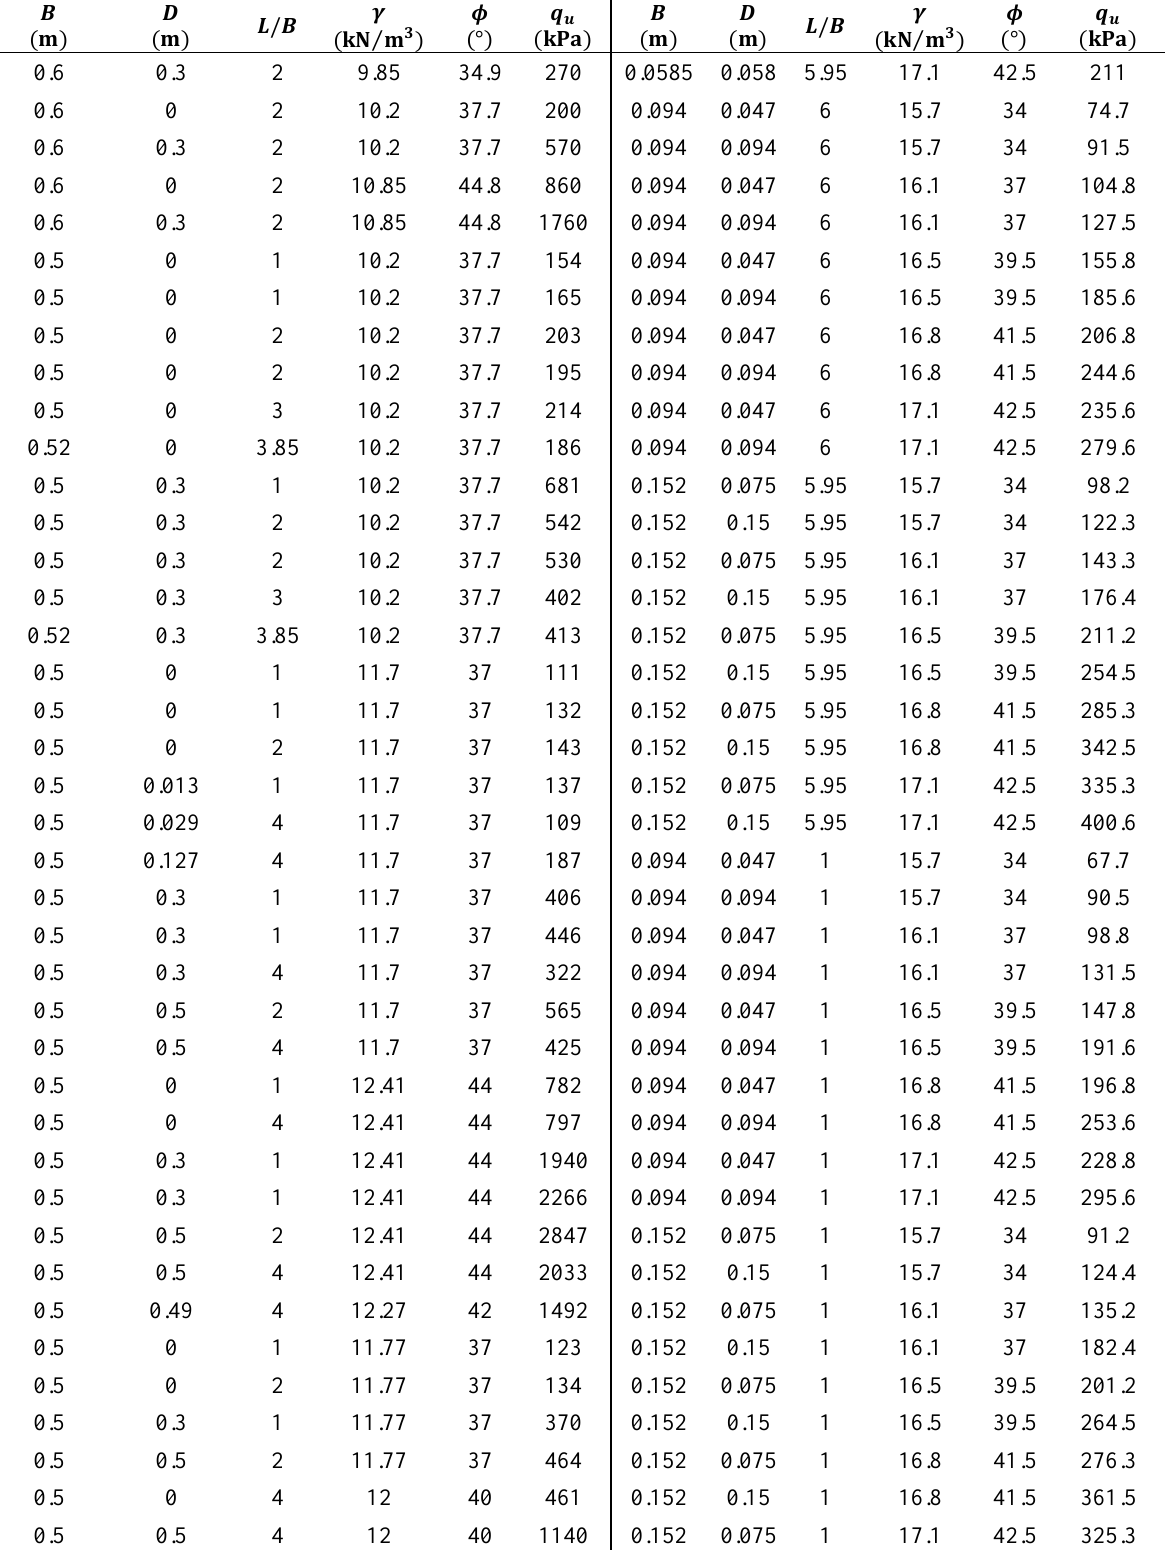
Table 1. The data used for developing the RF model (Kalinli et al, 2011; Padmini et al.,